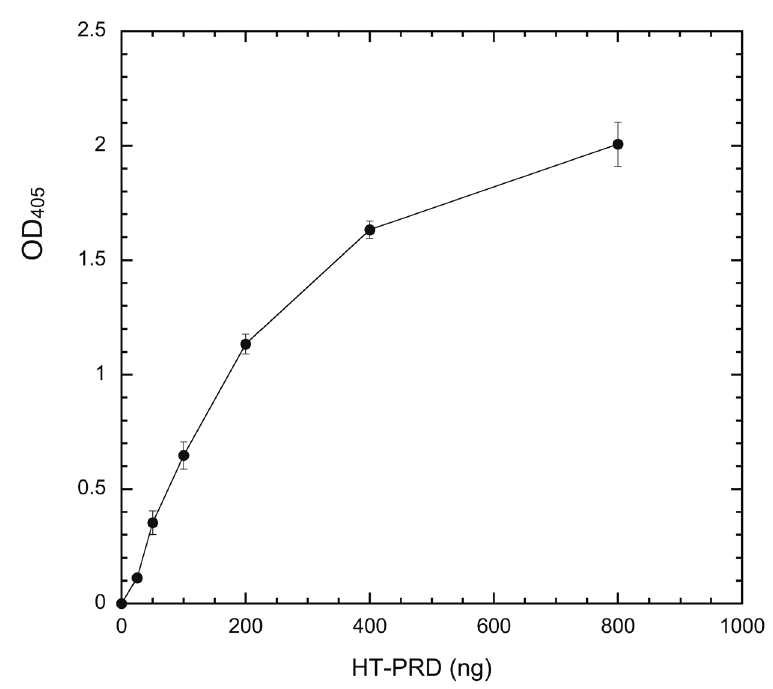
Figure 1. Coating ELISA plate with HT-PRD. Wells were incubated with indicated amounts of HT-PRD (0, 25, 50, 100, 200, 400, and 800 ng/well) at 4°C overnight and the level of coated proteins was then detected with anti-dynamin mAb Hudy-1 by following the sandwich ELISA protocol, as described in Methods (n = 4 for each data point).